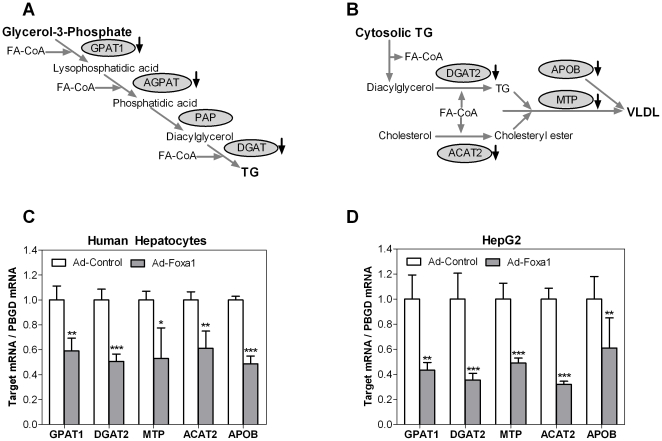
Foxa1 inhibits the expression of genes involved in TG and VLDL synthesis.Diagrams of TG (A) and VLDL (B) synthesis pathways in the liver. Human hepatocytes (C) and HepG2 cells (D) were infected with Ad-Foxa1 or Ad-Control (12 MOI for human hepatocytes and 24 MOI for HepG2) for 48 h, and the mRNA level of TAG and VLDL genes was measured by real-time Q-RT-PCR and normalized to the expression of the housekeeping PBGD mRNA. Data represent the mean±SD of 4–5 independent experiments. * p<0.05; ** p<0.01; *** p<0.001 in relation to Ad-Control infected cells. GPAT: glycerol-3 phosphate acyltransferase. AGPAT: 1-acylglycerol-3-phosphate-O-acyltransferase. DGAT: diacylglycerol acyltransferase. MTP: microsomal triglyceride transfer protein. ACAT: acyl coenzyme A: cholesterol acyltransferase. APOB: apolipoprotein B.